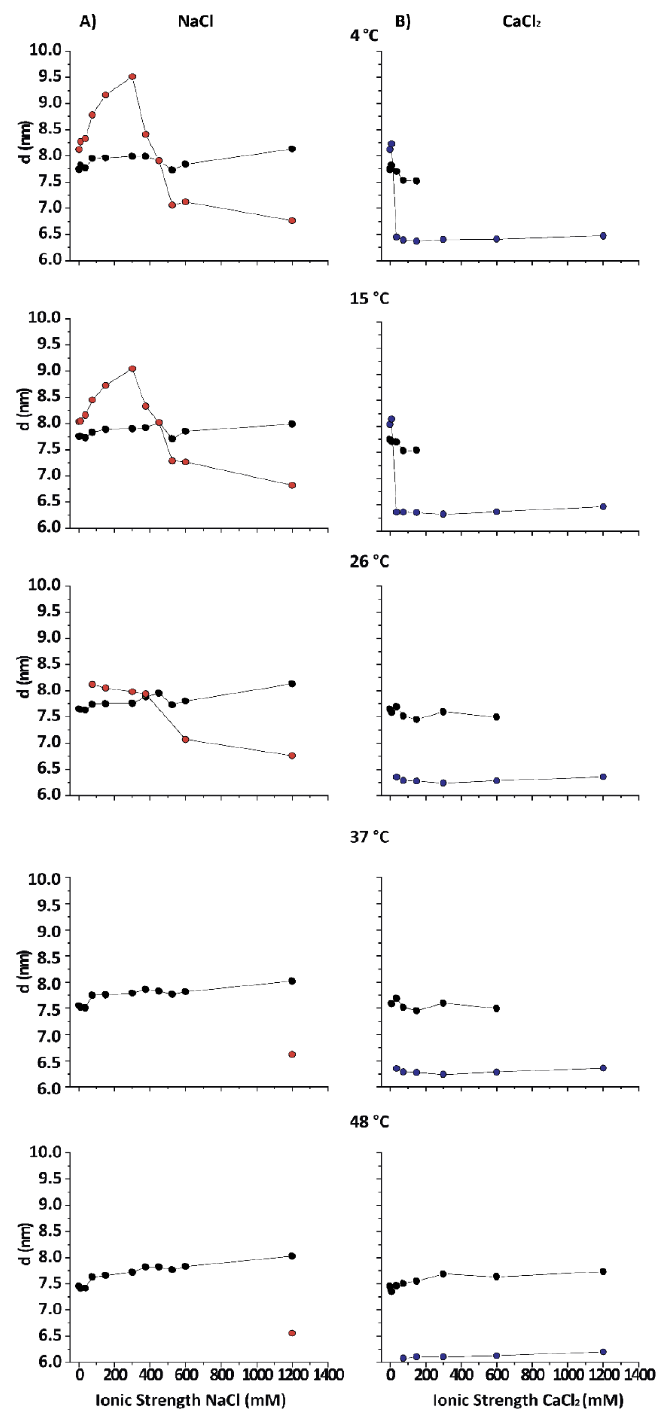
Figure 2. Periodicities ( d ) for PMMs phases under various temperature and IS conditions: ( A ) for NaCl solutions and ( B ) for CaCl 2 solutions; the numbers in panels refer to temperature. The nearly horizontal lines (black symbols) at d ≈ 7.4–8.0 nm indicate the native phase. Upper values are traditionally defined as the expanded, separated, or partially swelled phase, and lower values correspond to the (over)compacted phase. Several measurements, but not all, were taken in two independent repetitions, and the error was estimated to be between ≈ 0.2 nm (compacted and native phases) and ≈ 0.3 nm (expanded phase). Black dots: native phase; red dots: non-native phase in NaCl; blue dots: non-native phase in CaCl 2 .